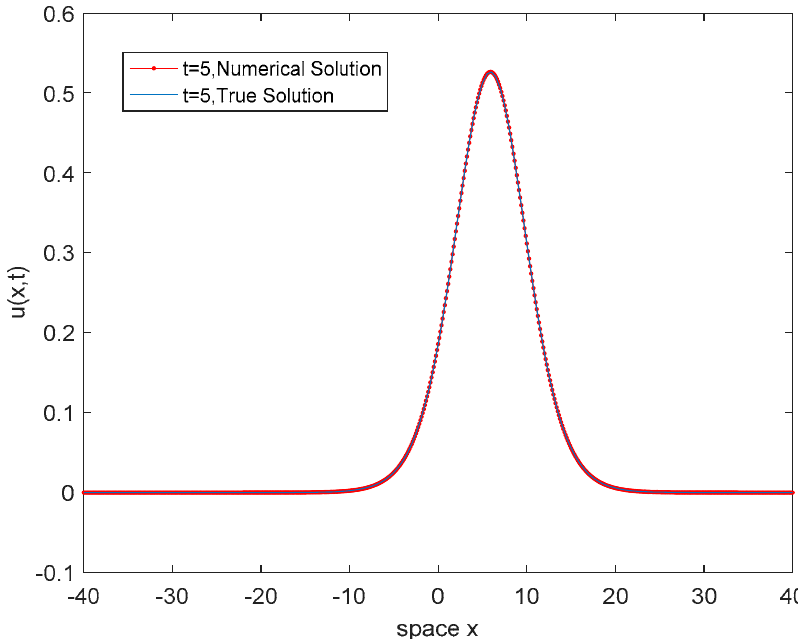
Figure 5. Numerical solution and exact solution with h = τ = 1/8 , t = 5.